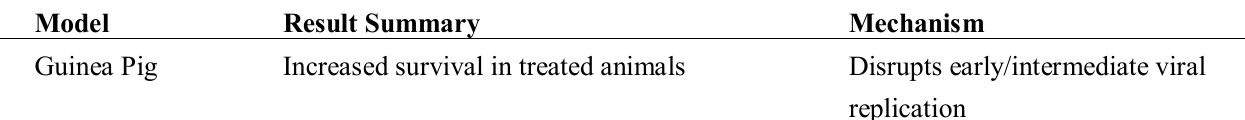
Table 4. Prophylactics and Therapeutics